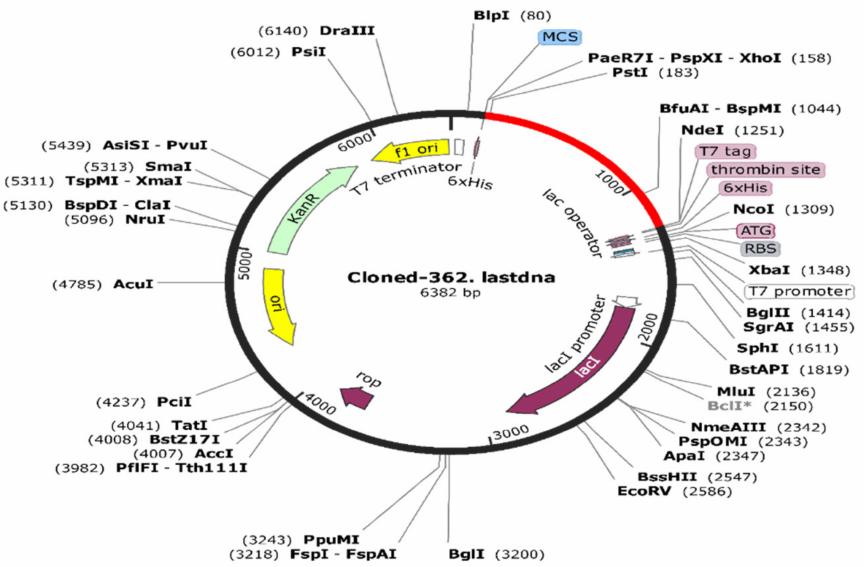
Figure 8. In silico cloning. The inserted optimized DNA sequences of proposed immunogenic construct in plasmid vector map pET-28a (+) with restriction sites of six nucleotides, XhoI (158) and NdeI (1251). The insert sequence is denoted by the red color while vector is denoted by the black color in the circular